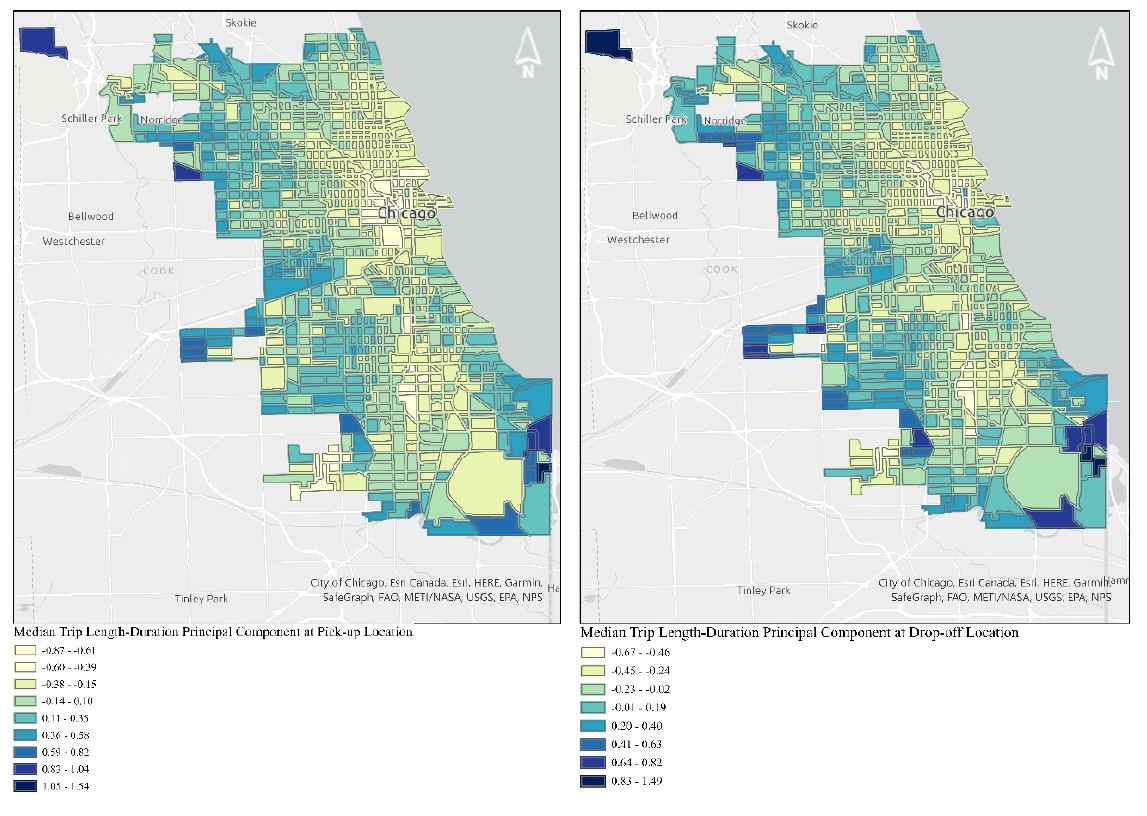
Figure 2: Median TNC Trip LDPC at Pick-up and drop-off Census